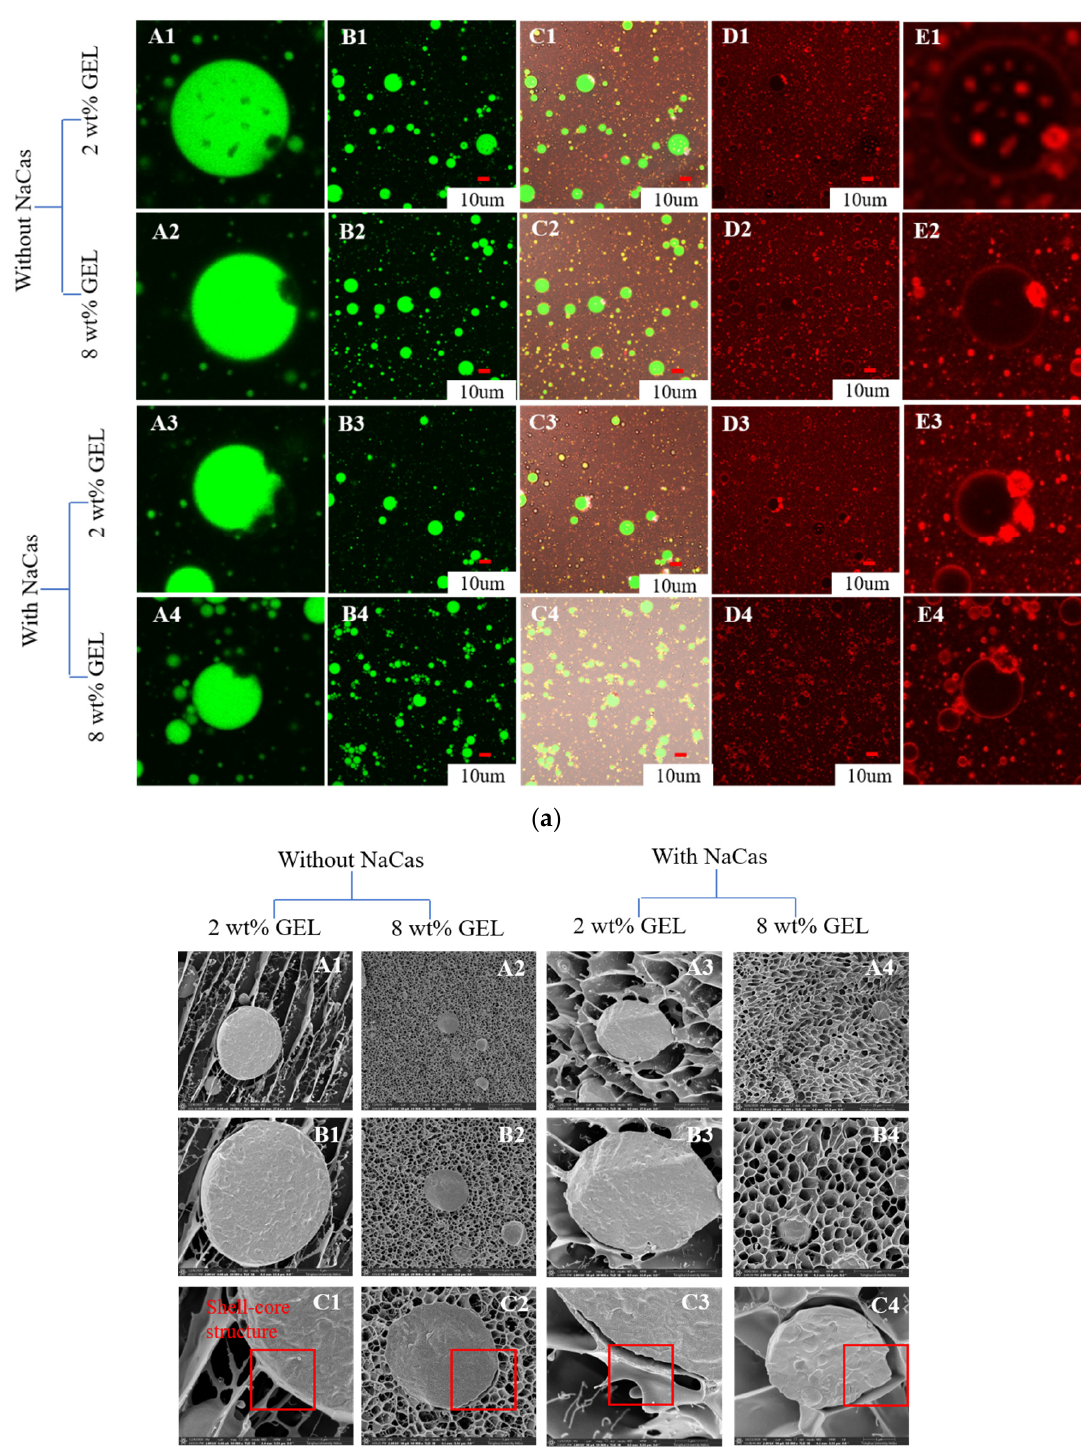
Figure 5. ( a ) CLSM images of the CaCO 3 S/O/W emulsions (A/B Oil phase was stained with Nile red, excitation at 488 nm; D/E, protein phase was stained with Nile blue, excitation at 635 nm (ii); C, combined image; columns A and E state that are details of the images of columns B and D, respectively). Scale bar: 10 µ m. (1, 2: 2, and 8 wt% GEL, without NaCas; 3,4: 2, and 8 wt% GEL, with NaCas). ( b ) Cryo-SEM images of the CaCO 3 S/O/W emulsions (A, 5000×; B, 20,000×; C, 50,000×); (1, 2: 2, and 8 wt% GEL, without NaCas; 3,4: 2, and 8 wt% GEL, with NaCas).